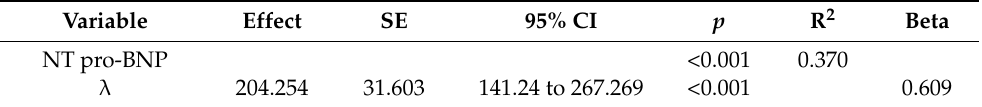
Table 9. Multivariable linear regression analysis for NT-proBNP concentration in the group with myocardial involvement where the amyloid is formed by monoclonal κ chains. Variable